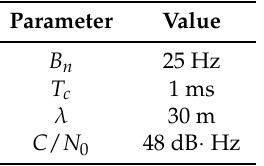
Table 1. Parameter settings of distance measurement performance of PRG method.